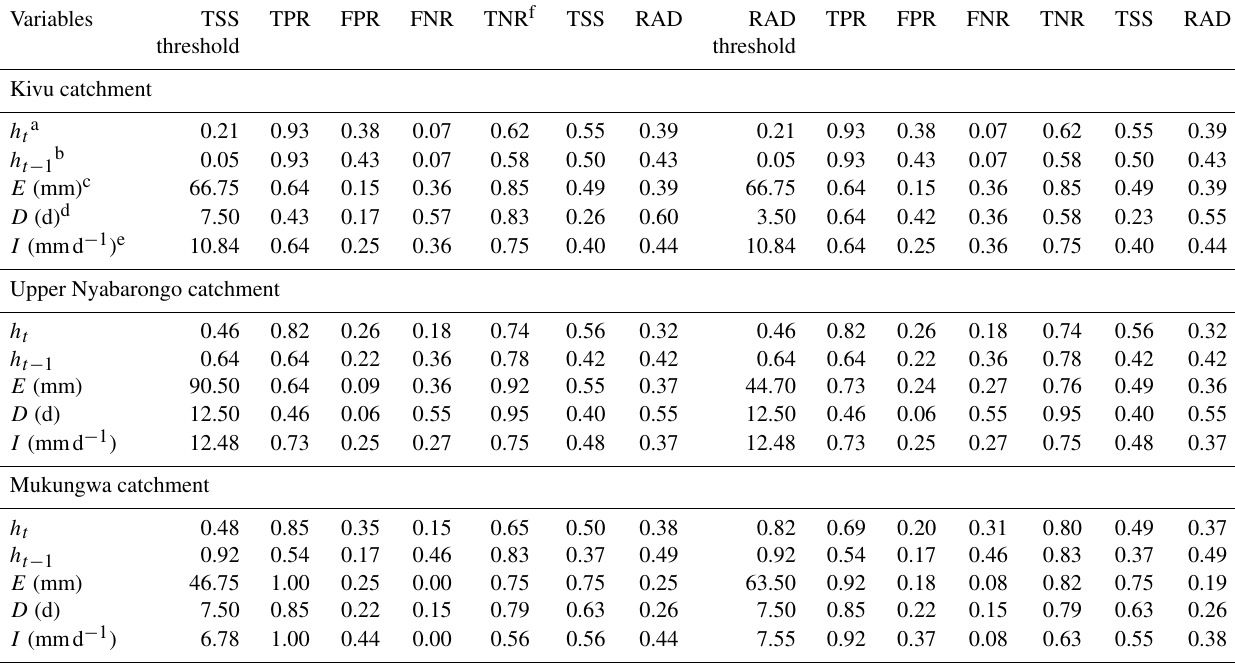
Table 1. Single variable landslide threshold definition with the maximum true skill statistics (TSS) and minimum radial distance (Rad) and their predictive power.